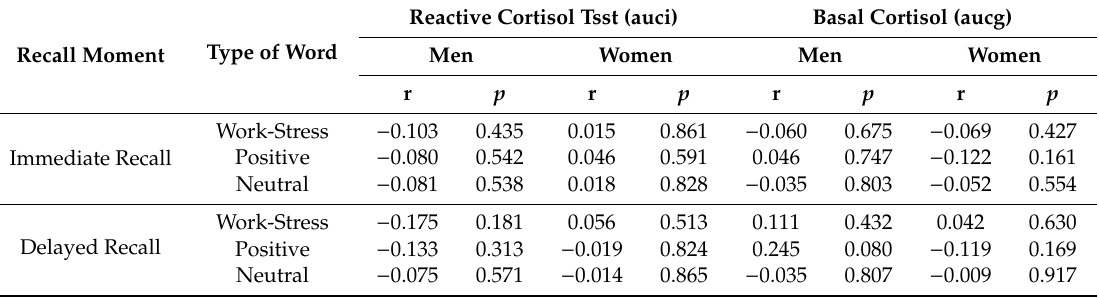
Table 3. Pearson Correlation coe ffi cients between recall of di ff erent type of words and reactive / diurnal cortisol